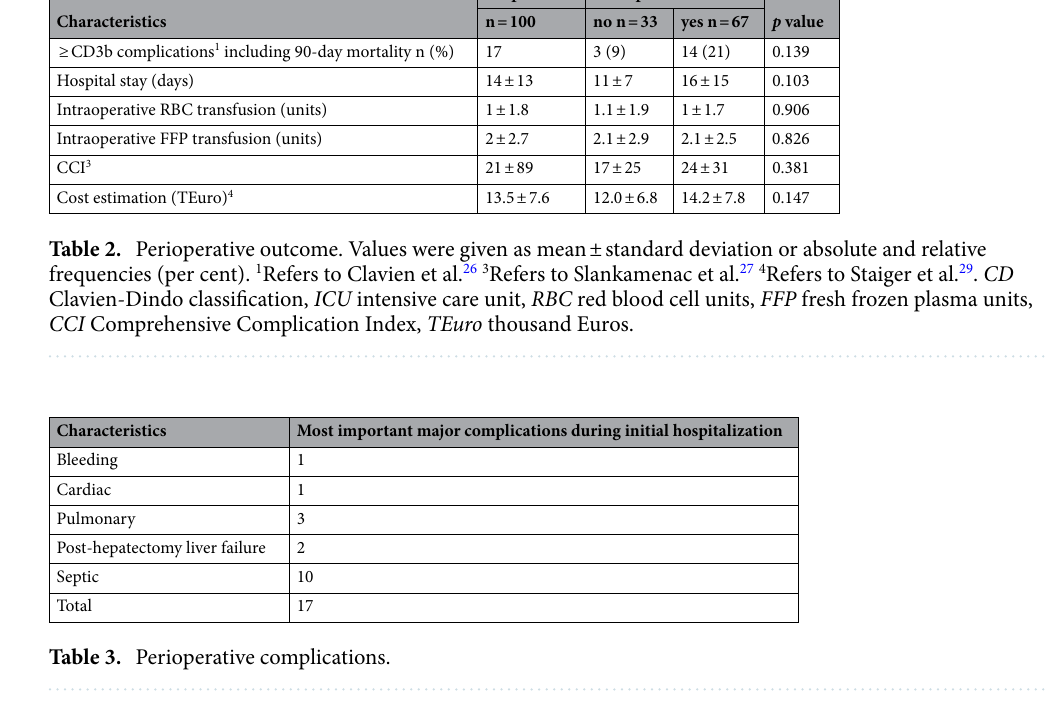
All patients Osteopenia